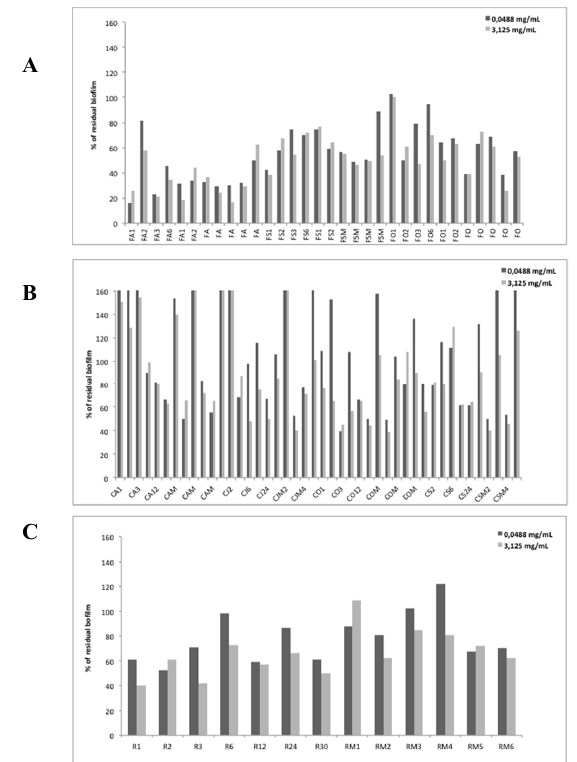
Figure 1. Effect of EOs from Foeniculum vulgare Miller (FV) ( A ), Calamintha nepeta (L.) Savi subsp. glandulosa (Req.) Ball (CG) ( B ), and Ridolfia segetum Moris (RS) ( C ) on biofilm formation of P. aeruginosa PaO1. Data are reported as percentage of residual biofilm after the treatment in comparison with the untreated one. Each data point is composed of four independent experiments each performed at least in triplicate.